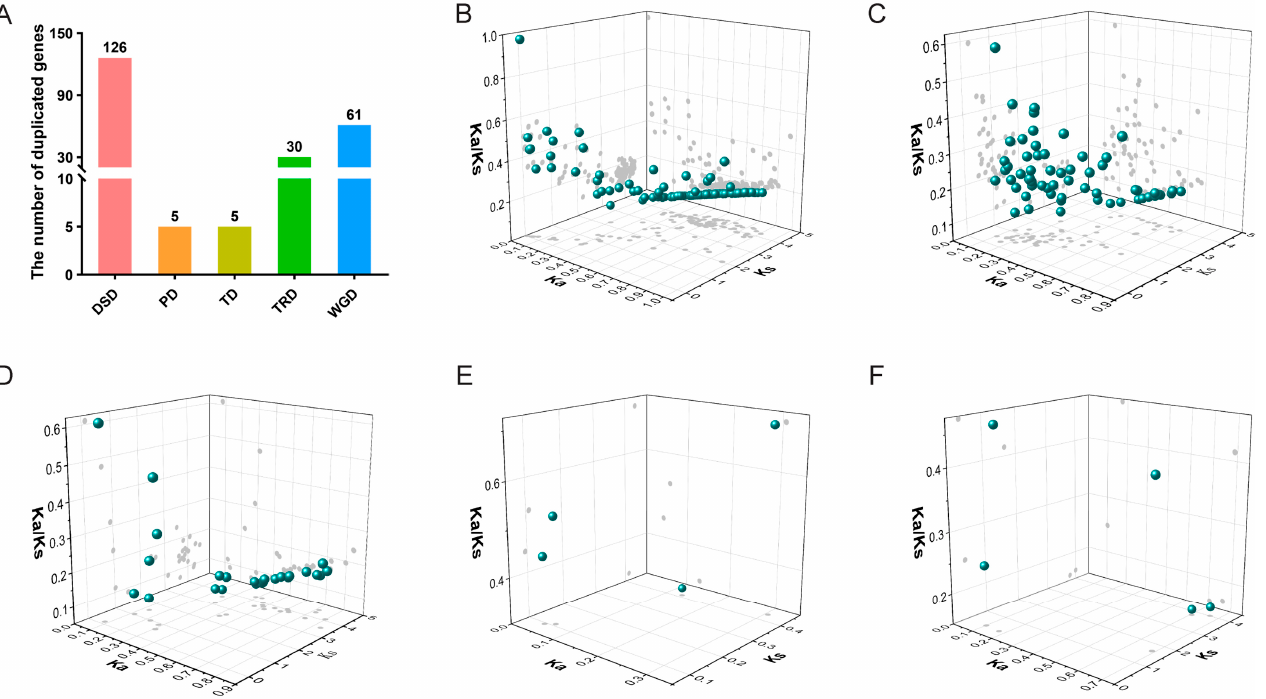
Figure 6. Gene duplication events of IabHLH genes. ( A ) The number distribution of IabHLH duplicated gene pairs in five duplication events. ( B – F ) The Ka, Ks, and Ka/Ks value distribution of the duplicated gene pairs in five gene duplication events. The DSD, WGD, TRD, PD, and TD events were from ( B – F ), respectively. More information concerning the duplicated genes in five gene duplication events was shown in Table S4.